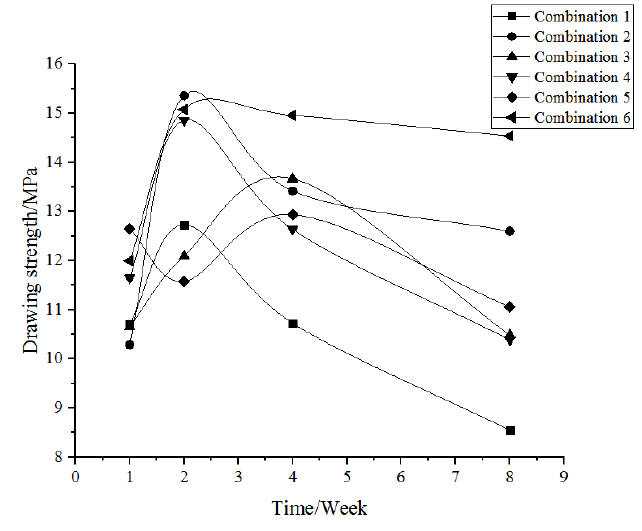
Figure 8. Room temperature water bath drawing strength diagram.